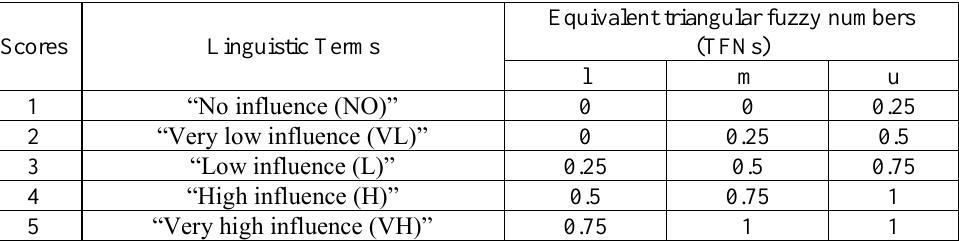
Table 2. Fuzzy Linguistic